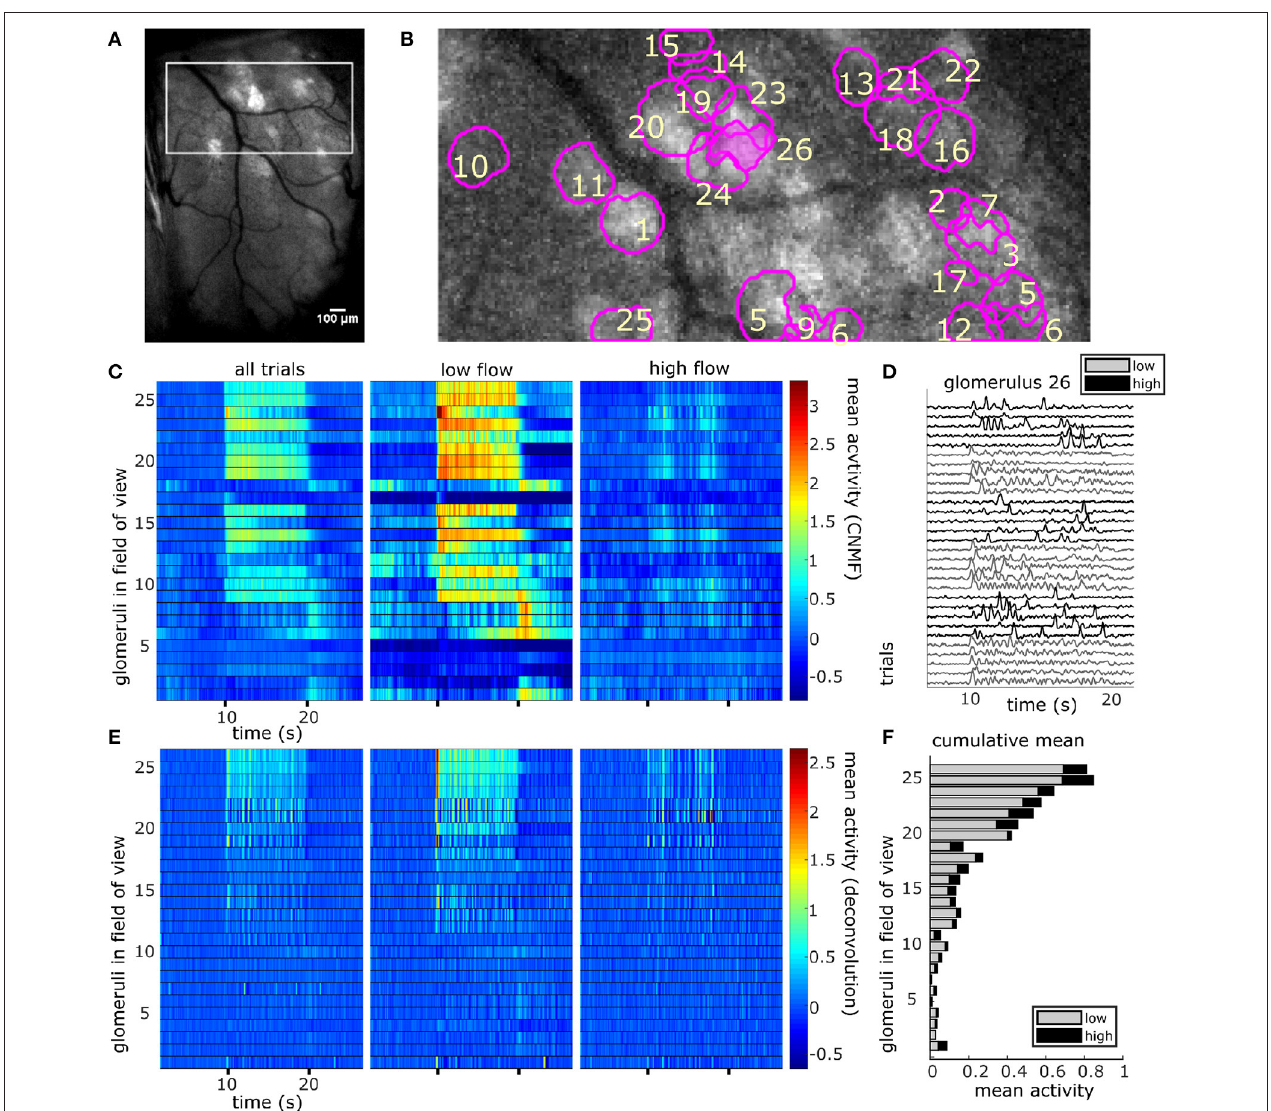
FIGURE 4 | The spatial and temporal decomposition of CNMF identifies glomeruli and denoises their traces. (A) The white box outlines the FOV used for analysis as it relates to the larger recording window. The image shows the standard deviation projection of the aligned recording during a single odor presentation. (B) Mean subtracted maximum projection of the same trial overlaid with ROIs from CNMF spatial decomposition shows segmentation of glomeruli for a single FOV using CNMF spatial decomposition. The spatial decomposition of the FOV results in 26 glomeruli (four dropped units after merge analysis not pictured) as outlined and numbered. (C) Shows the mean traces of each glomerulus’s CNMF temporal decomposition within each flow condition (left to right : all trials, low flow, high flow). Trials sorted by magnitude of normalized mean deconvolved response (E) during odor exposure. (D) The deconvolved CNMF response of a single glomerulus [pink fill (B) ] to all low (gray) and high (black) flow trials across the recording session shows glomerular responses vary due to the unique odor concentration dynamics of each plume. (E) Deconvolution accelerates dynamics of glomerular responses as shown by the mean deconvolved traces of the corresponding glomeruli depicted in (C) . (F) The cumulative mean, a sum of the mean responses for each glomerulus in low and high flow, are plotted as a stacked bar graph so that comparisons between mean responses can be made within and across glomeruli simultaneously. Mean responses are calculated for the deconvolution (E) within each flow condition during the plume release and vary significantly between conditions [ t (110) = 11.43, p < 0.001] with higher average responses in low